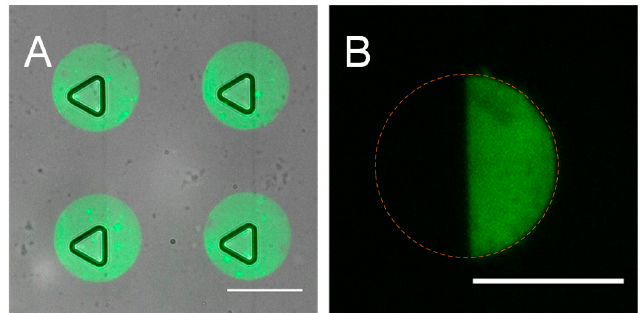
Figure 4. Device fabrication. ( A ) Overlapped images of paired fluorescein isothiocyanate labeled poly- L -lysine (PLL-FITC) patterns and microwells within a microchannel. Scale bar is 100 μ m; ( B ) fluorescence image of a PLL-FITC pattern after a 30 s O 2 plasma treatment with the right side covered by a piece of PDMS. Dotted circle shows the original shape of the pattern before O 2 plasma treatment. The protected right side maintained high fluorescence while the exposed left side was totally damaged. Scale bar is 100 μ m.